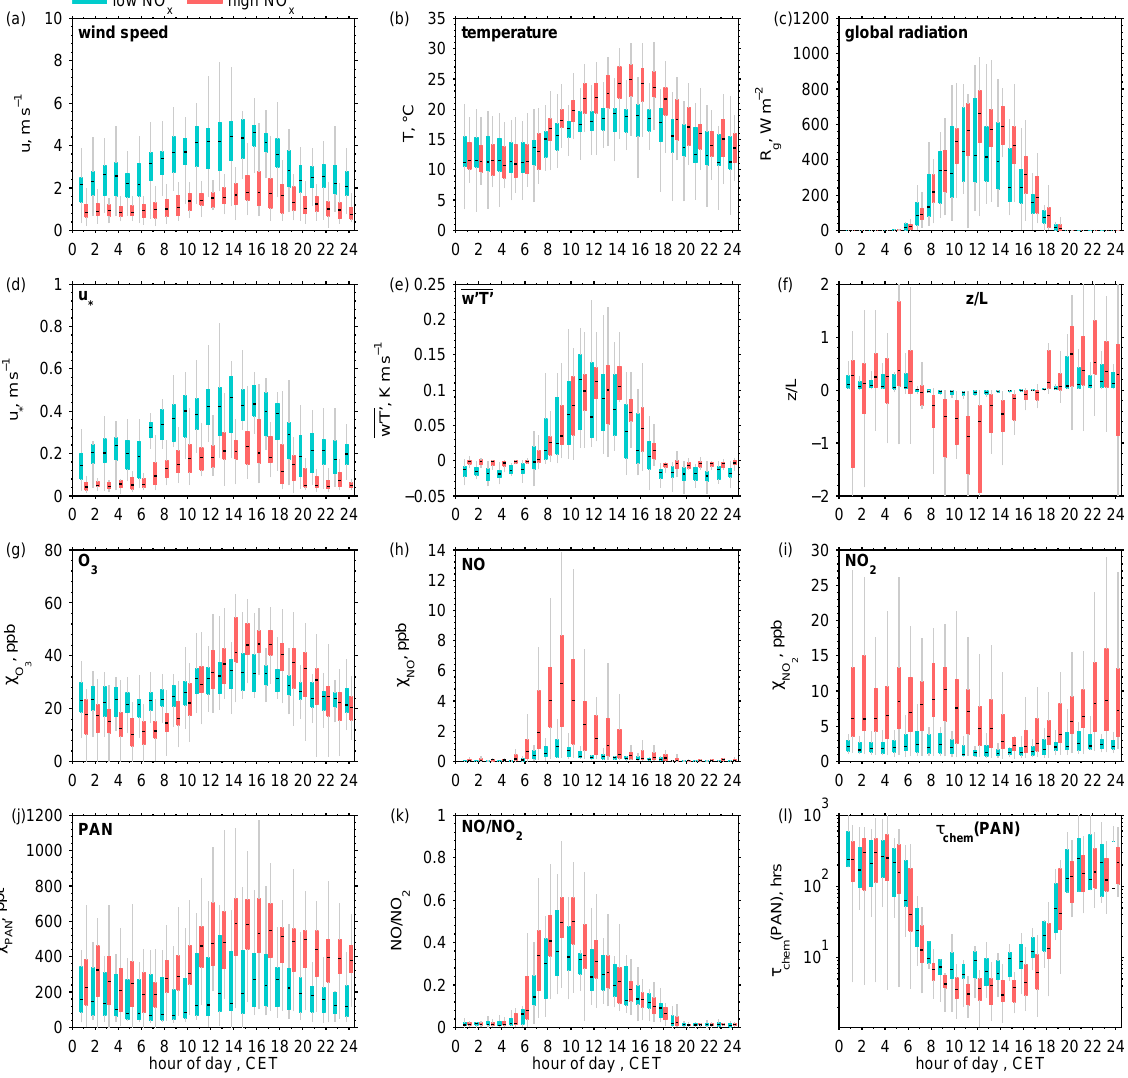
Figure 2. Diurnal boxplot statistics for the period from 29 June to 21 October 2011 at the Mainz Finthen grassland site, characterizing low and high NO x periods according to the prevailing meteorological conditions (a–f) , mixing ratios of the O 3 –NO–NO 2 triad (g–i) and PAN mixing ratios including the NO / NO 2 ratio used for the calculation of τ chem (j–l)